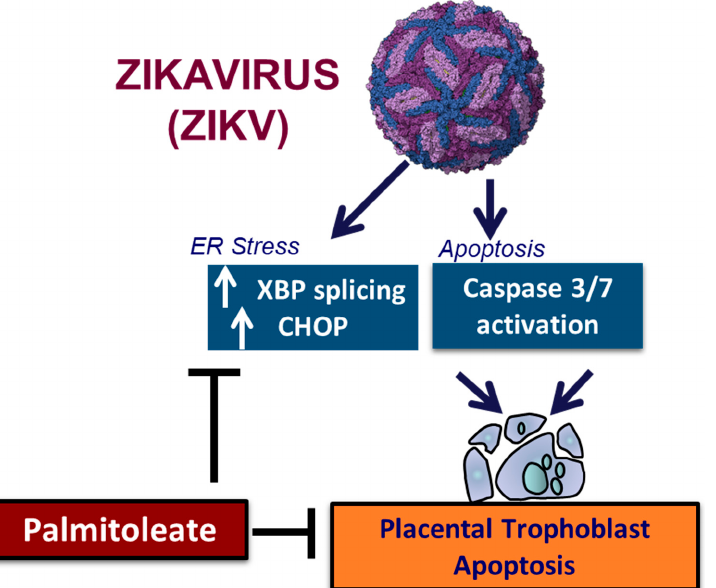
Figure 4. The schematic diagram represents palmitoleate protection against ZIKV-induced ER stress and apoptosis in placental trophoblasts. Table 3. ZIKV infection in placental trophoblast apoptosis involves activation of JNK and endoplas- mic reticulum and Palmitoleate protects against ZIKV-induced ER stress and apoptosis in tropho- blasts.